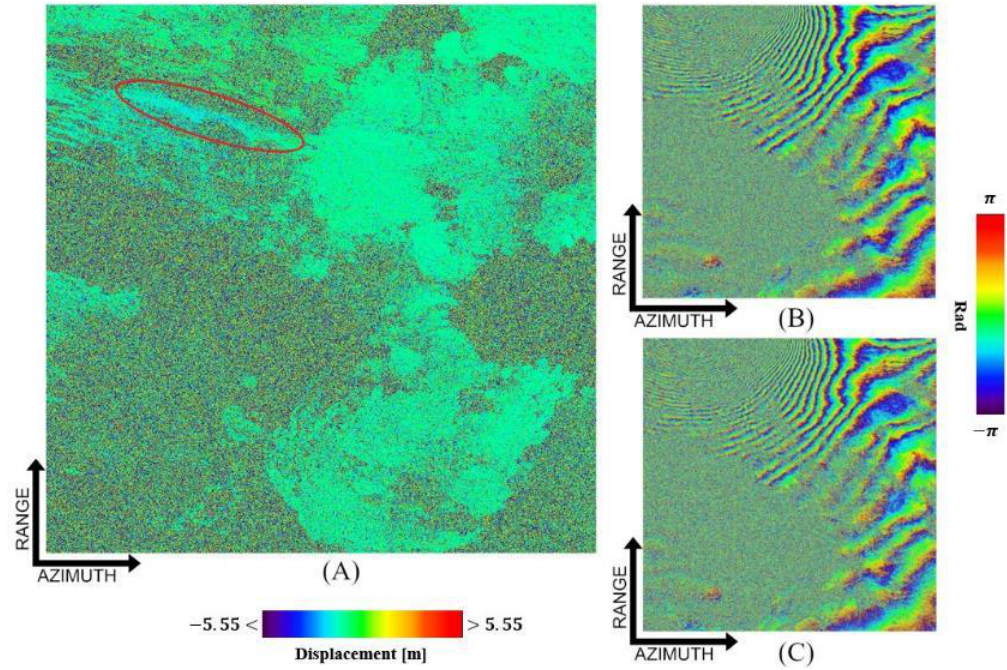
Figure 10. ( A ) Multiple aperture SAR interferometry (MAI) and ( B , C ) forward- and backward-looking interferograms of the Afar depression zone, generated from a pair of the ASAR acquisitions that were collected on 19 December 2005 and 25 August 2008, respectively. Red circle identifies the main fault trace.